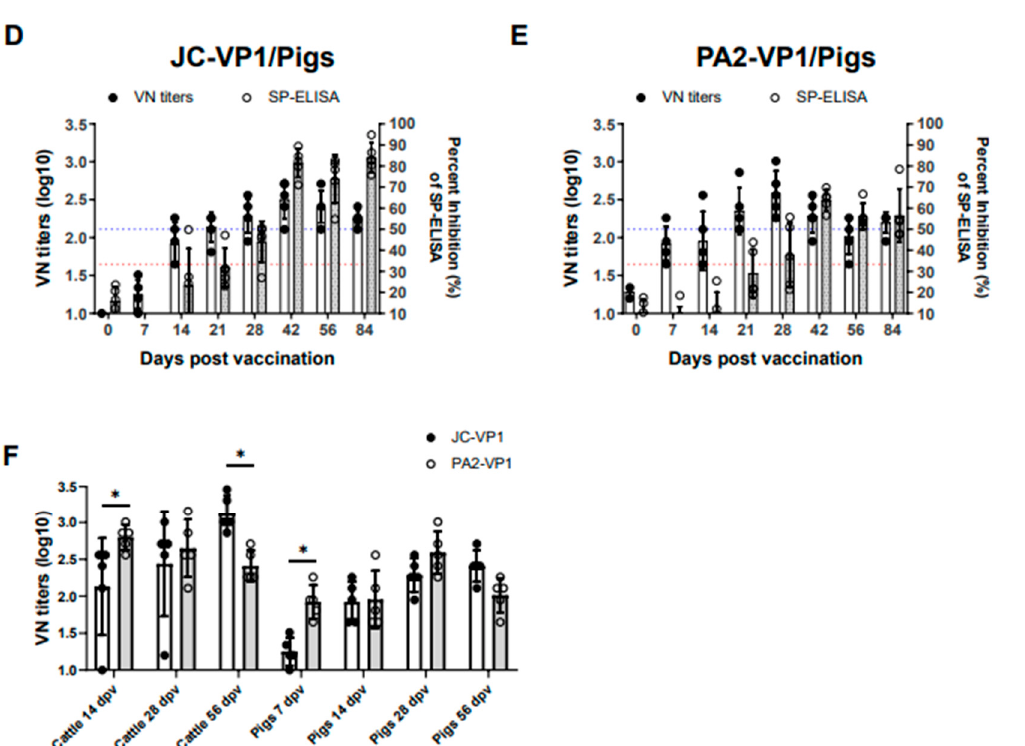
Figure 2. Antibody responses of cattle and pigs vaccinated with either JC-VP1 or PA2-VP1. Schematic diagram of study strategy ( A ). Neutralizing antibody titers and SP ELISA in cattle vaccinated with JC-VP1 ( B ) and PA2-VP1 ( C ). Cattle were inoculated with a single dose (15 µ g/dose of inactivated antigen mixed with ISA 206, saponin, and aluminum hydroxide gel adjuvant). Neutralizing antibody titers and SP ELISA in pigs vaccinated with JC-VP1 ( D ) and PA2-VP1 ( E ). Percent inhibition (PI) > 50 was considered the cutoff of a positive reaction (blue dashed line). VN titers (log10) > 1.65 were regarded as positive (red dashed line). The pigs were inoculated with a second vaccination (15 µ g/dose of inactivated antigen mixed with ISA 206, saponin, and aluminum hydroxide gel adjuvant) at 28 dpv. Comparative analysis of JC-VP1 and PA2-VP1 in vaccinated cattle and pigs ( F ). Statistical analyses were performed ANOVA and t test. ∗ p < 0.05.